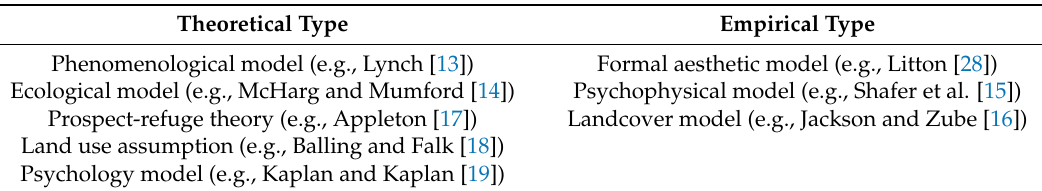
Table 1. Classification of the scenic beauty estimation method development logic.